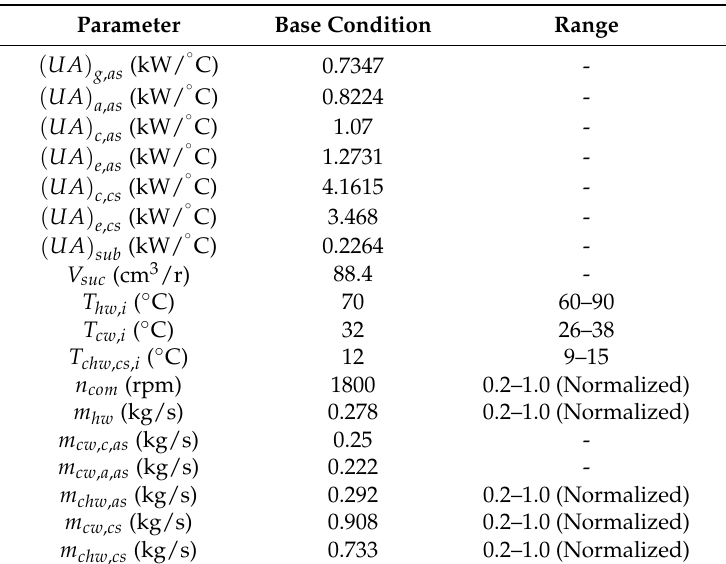
Figure 2. Schematics of prototype. Table 1. Condition of system.